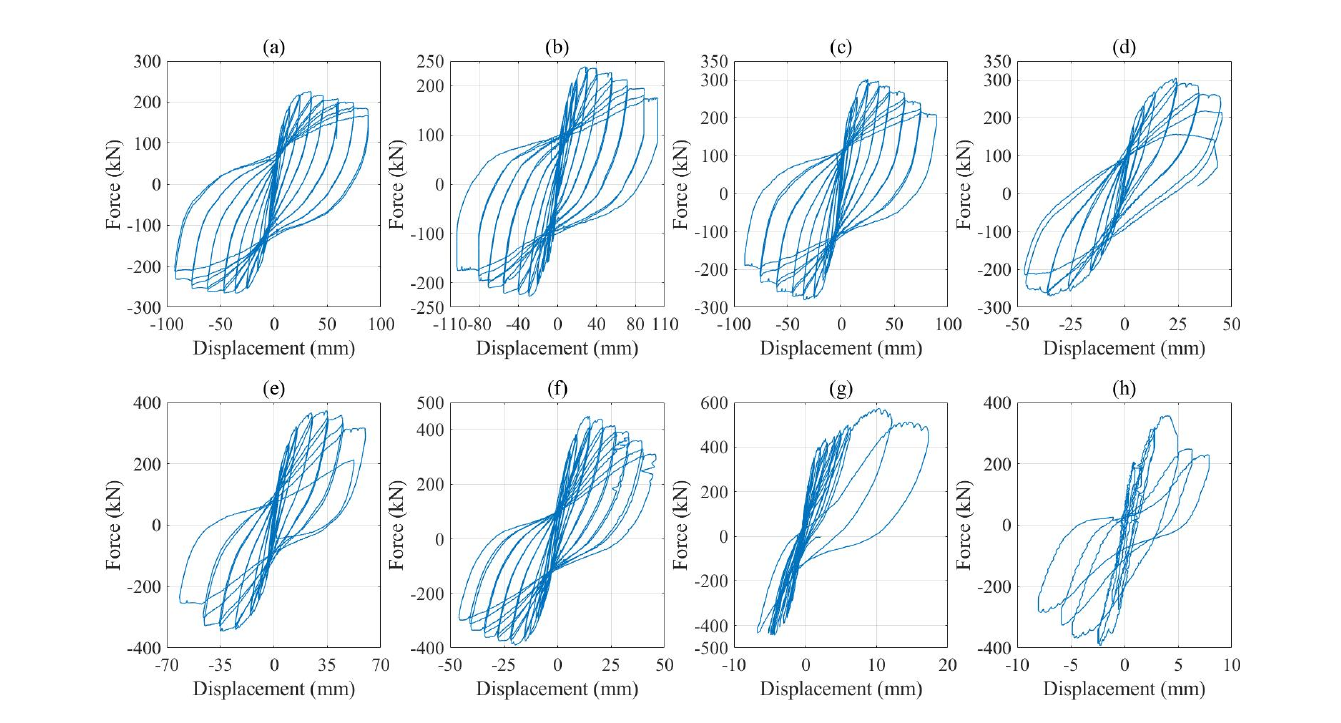
Figure 12. Force–displacement hysteresis curves diagram. Images ( a – h ) correspond to the eight RC columns used in the